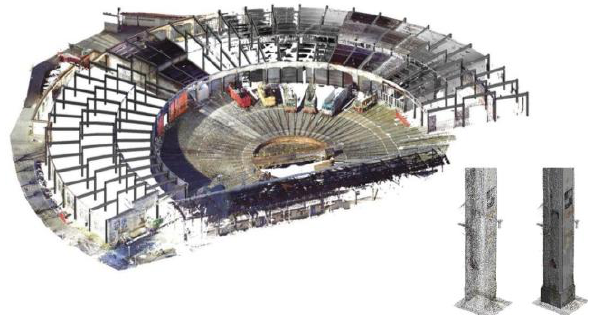
Figure 5. Comparison between the point cloud and the structural system of beams and pillars; on the right a cropped portion of the point cloud and the overlapping of the BIM model of a structural pillar parameters were added: some for the GRADE (GRAphic DEtail controls (Level of Development, meant as the degree of reliability of information associated with different elements).